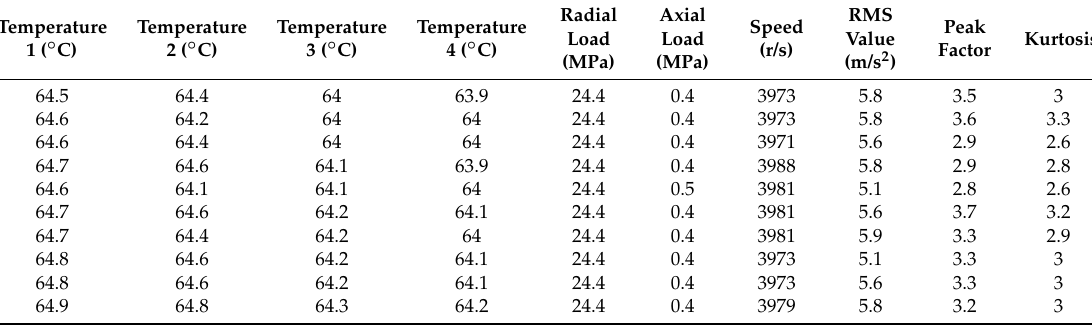
Table 4. Part data of the test machine status during normal wear of